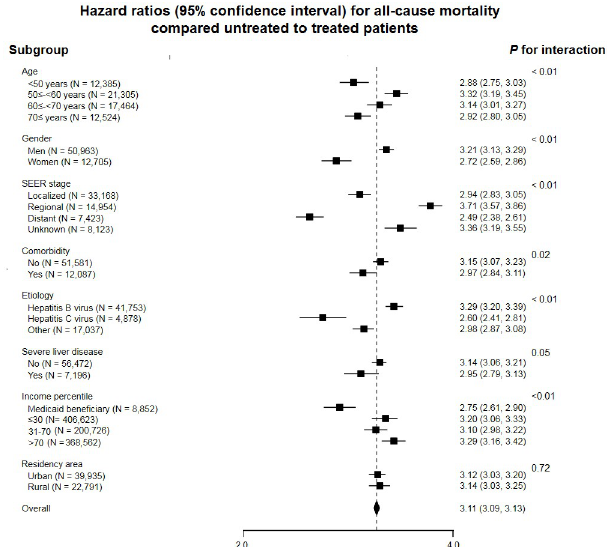
Fig 2. Hazard ratios (95% confidence intervals) for mortality comparing untreated with treated patients with hepatocellular carcinoma in selected subgroups. Adjusted for sex, age, year of HCC diagnosis, SEER stage, income percentile (Medical aid, � 30 th , > 30 th – 70 th , and > 70th), residency area (urban vs rural), comorbidities, etiology, and severity of liver disease.